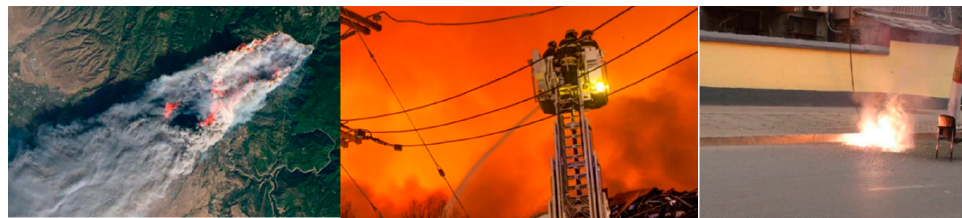
Figure 1. Fire potentially caused by the ground fault in electric distribution networks.